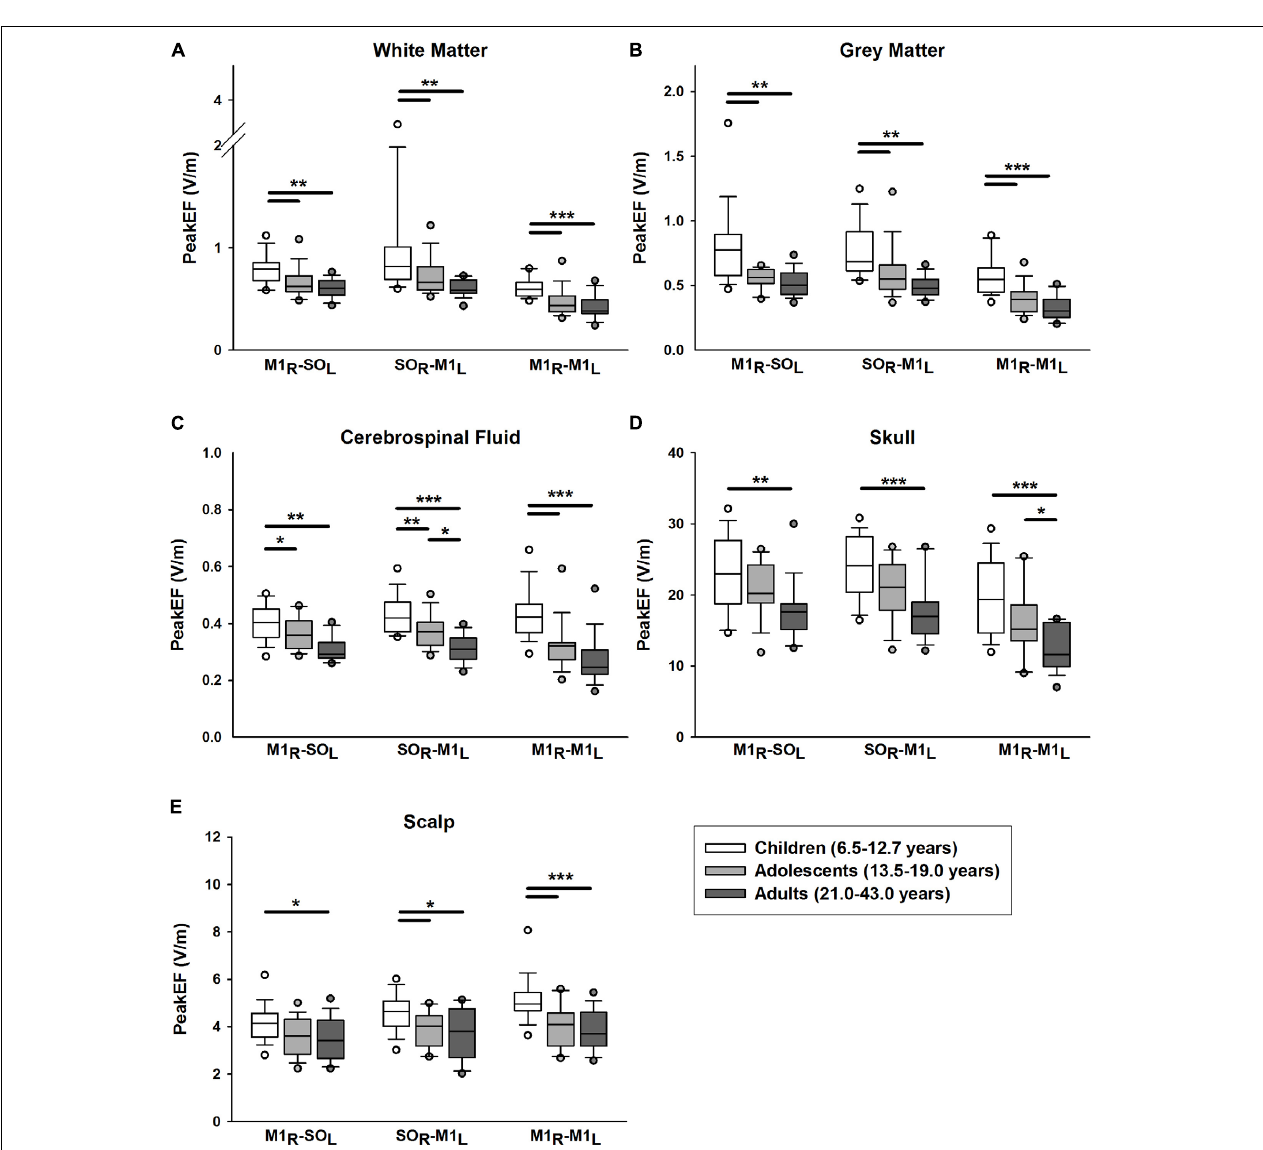
FIGURE 3 | Peak electric fields (PeakEF) induced by anodal, cathodal, and bihemispheric tDCS montages in children (white), adolescents (light gray) and (dark gray) by tissue type as follows: (A) white matter, (B) gray matter, (C) cerebrospinal fluid, (D) skull, and (E ) scalp. ∗ p < 0.05, ∗∗ p < 0.01, ∗∗∗ p < 0.001.